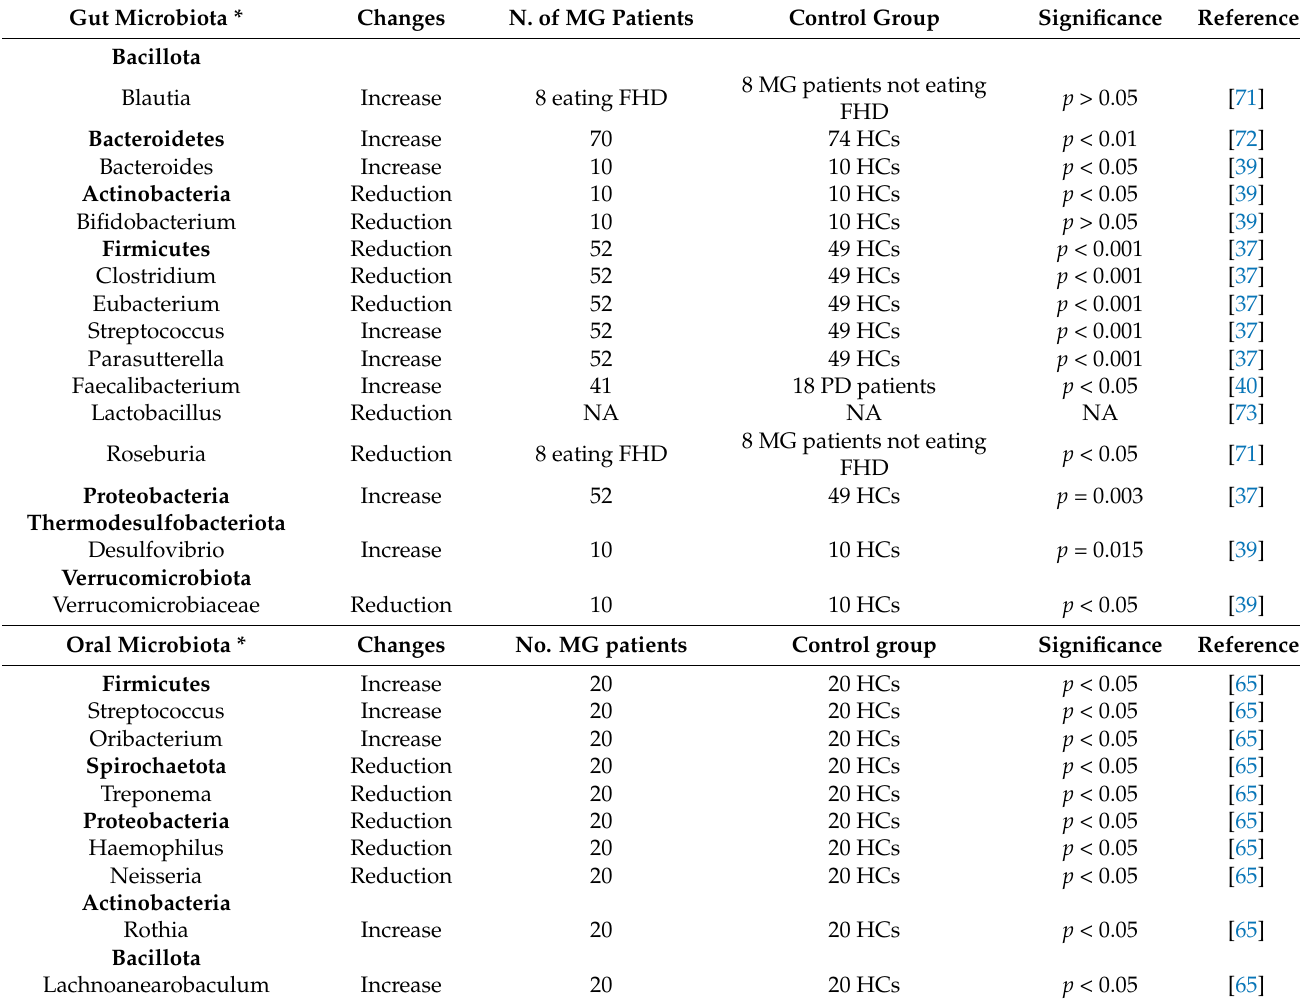
Table 1. Human microbiota changes in patients with myasthenia